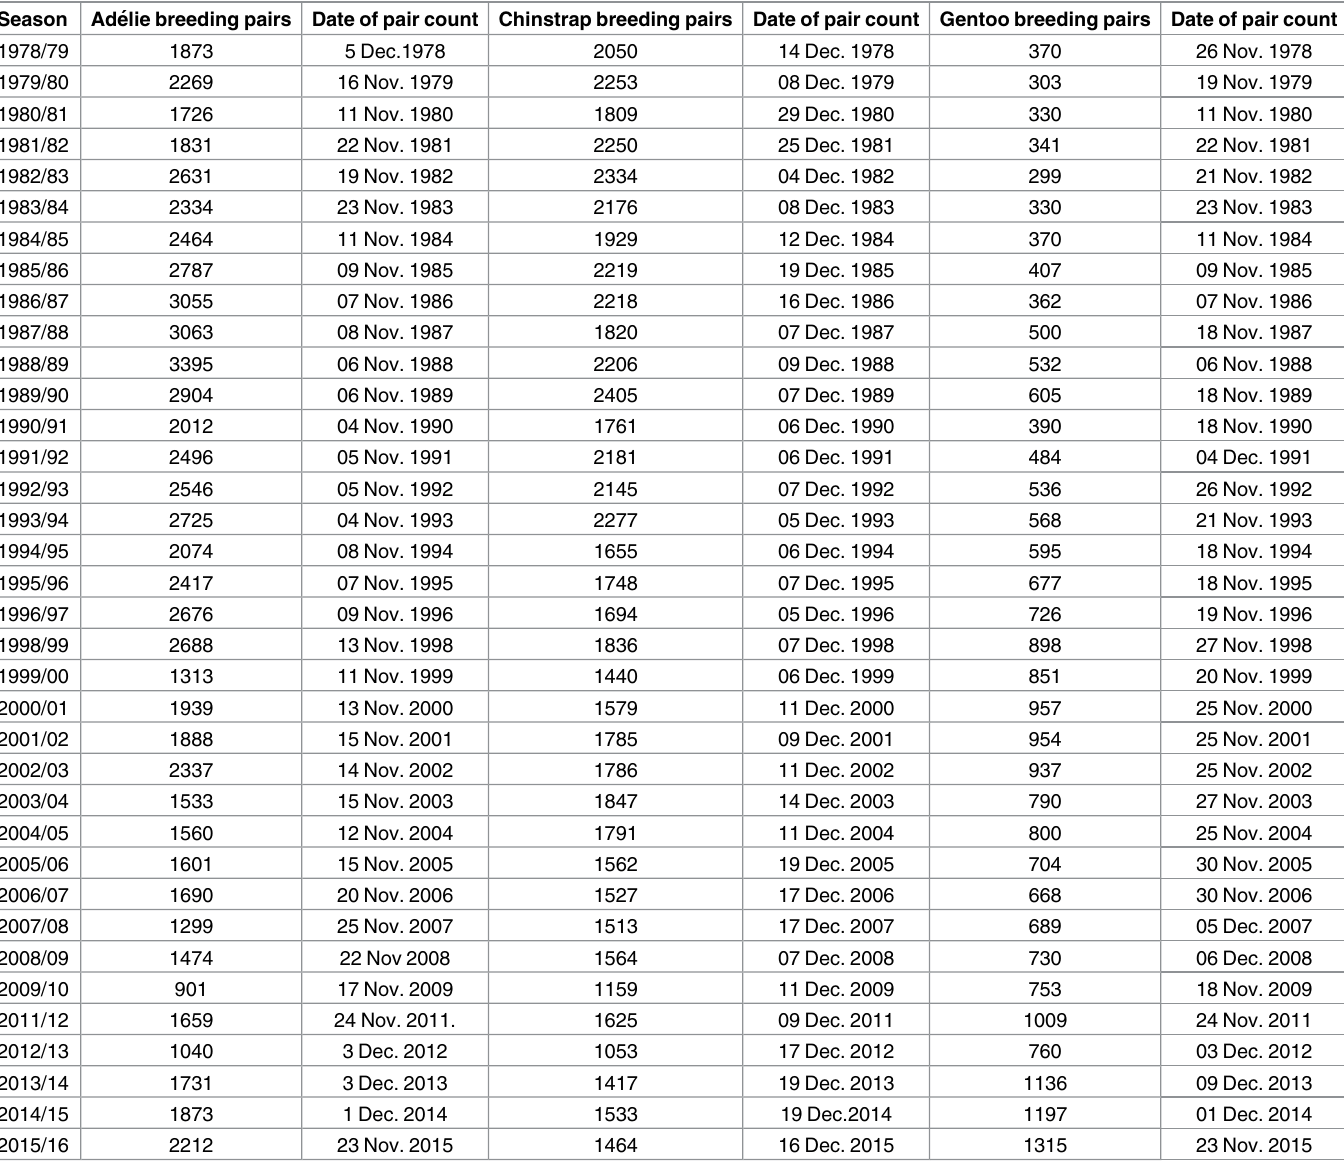
Table 2. Pairs of Ade´lie, chinstrap and gentoo penguins recorded in study areas at Signy Island 1978/79–2015/16. Season Ade´lie breeding pairs Date of pair count Chinstrap breeding pairs Date of pair count Gentoo breeding pairs Date of pair